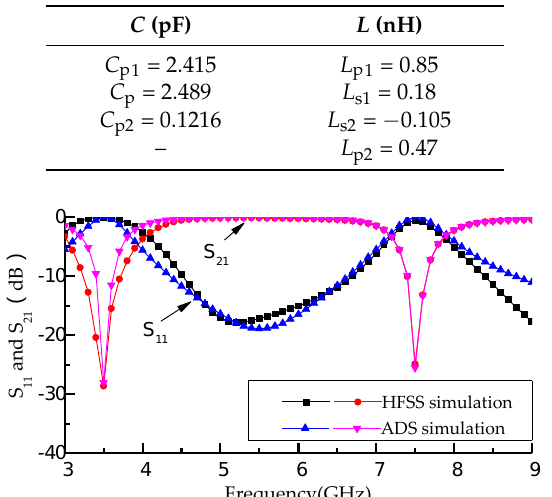
Figure 6. The comparison of simulation results by using high frequency structure simulator (HFSS) and advanced design system (ADS).